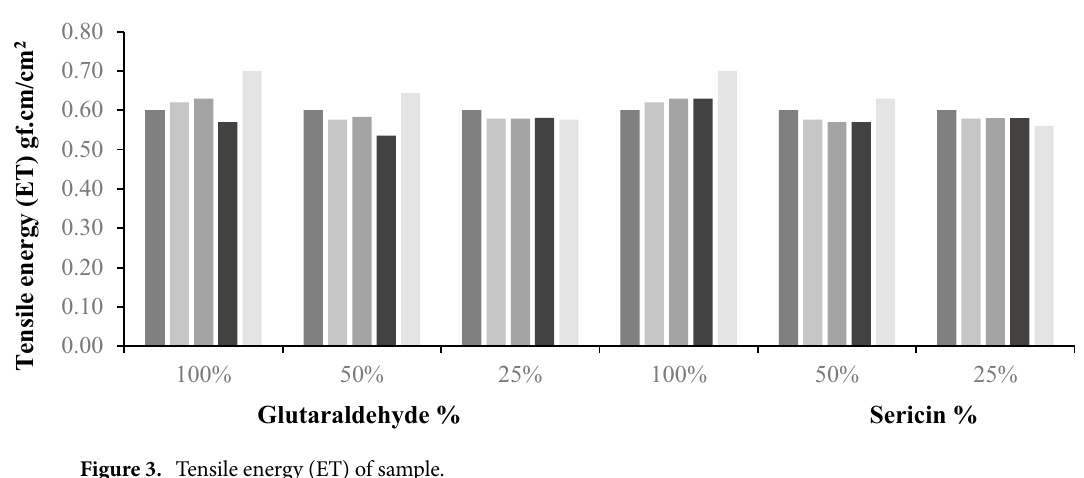
Figure 3. Tensile energy (ET) of